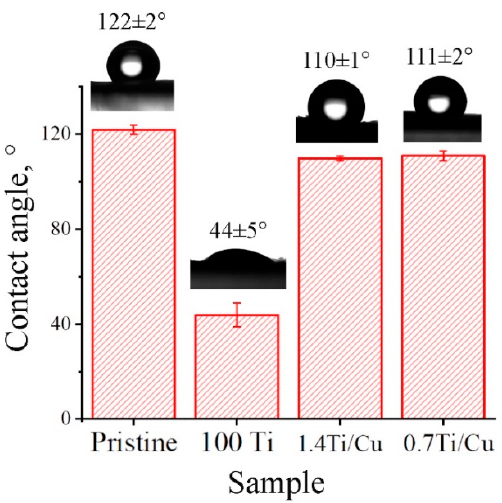
Figure 3. Water contact angle values of modified VDF-TeFE sample surfaces .